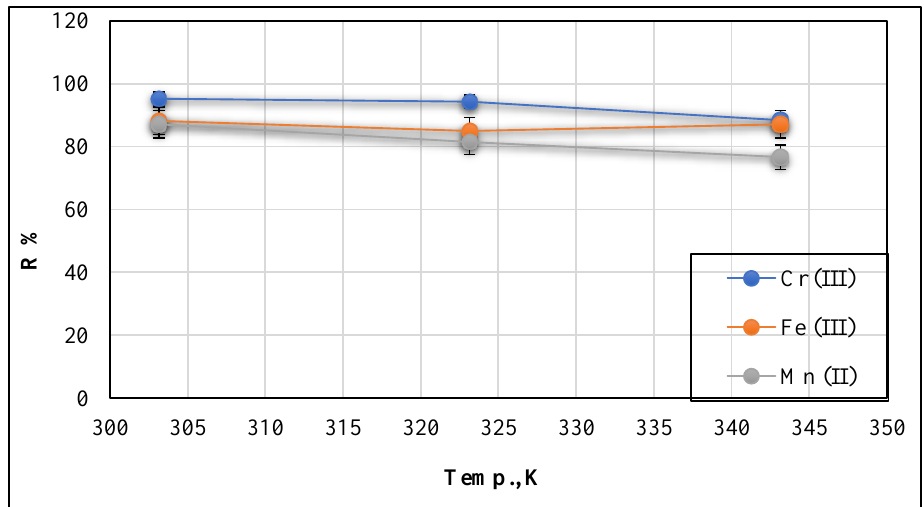
Figure 13. Effect of temperature on Cr (III), Fe (III), and Mn (II) removal at Conc. 20 mg/L and pH 9.